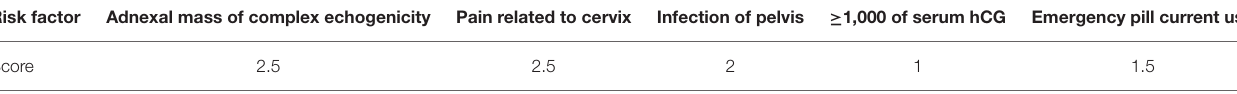
TABLE 3 | Predictive ectopic pregnancy scoring model, with the acronym APrIlE. Risk factor